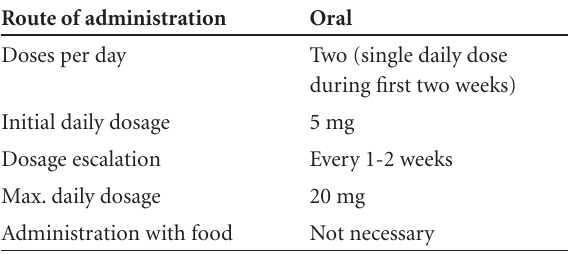
Table 3. Posology of